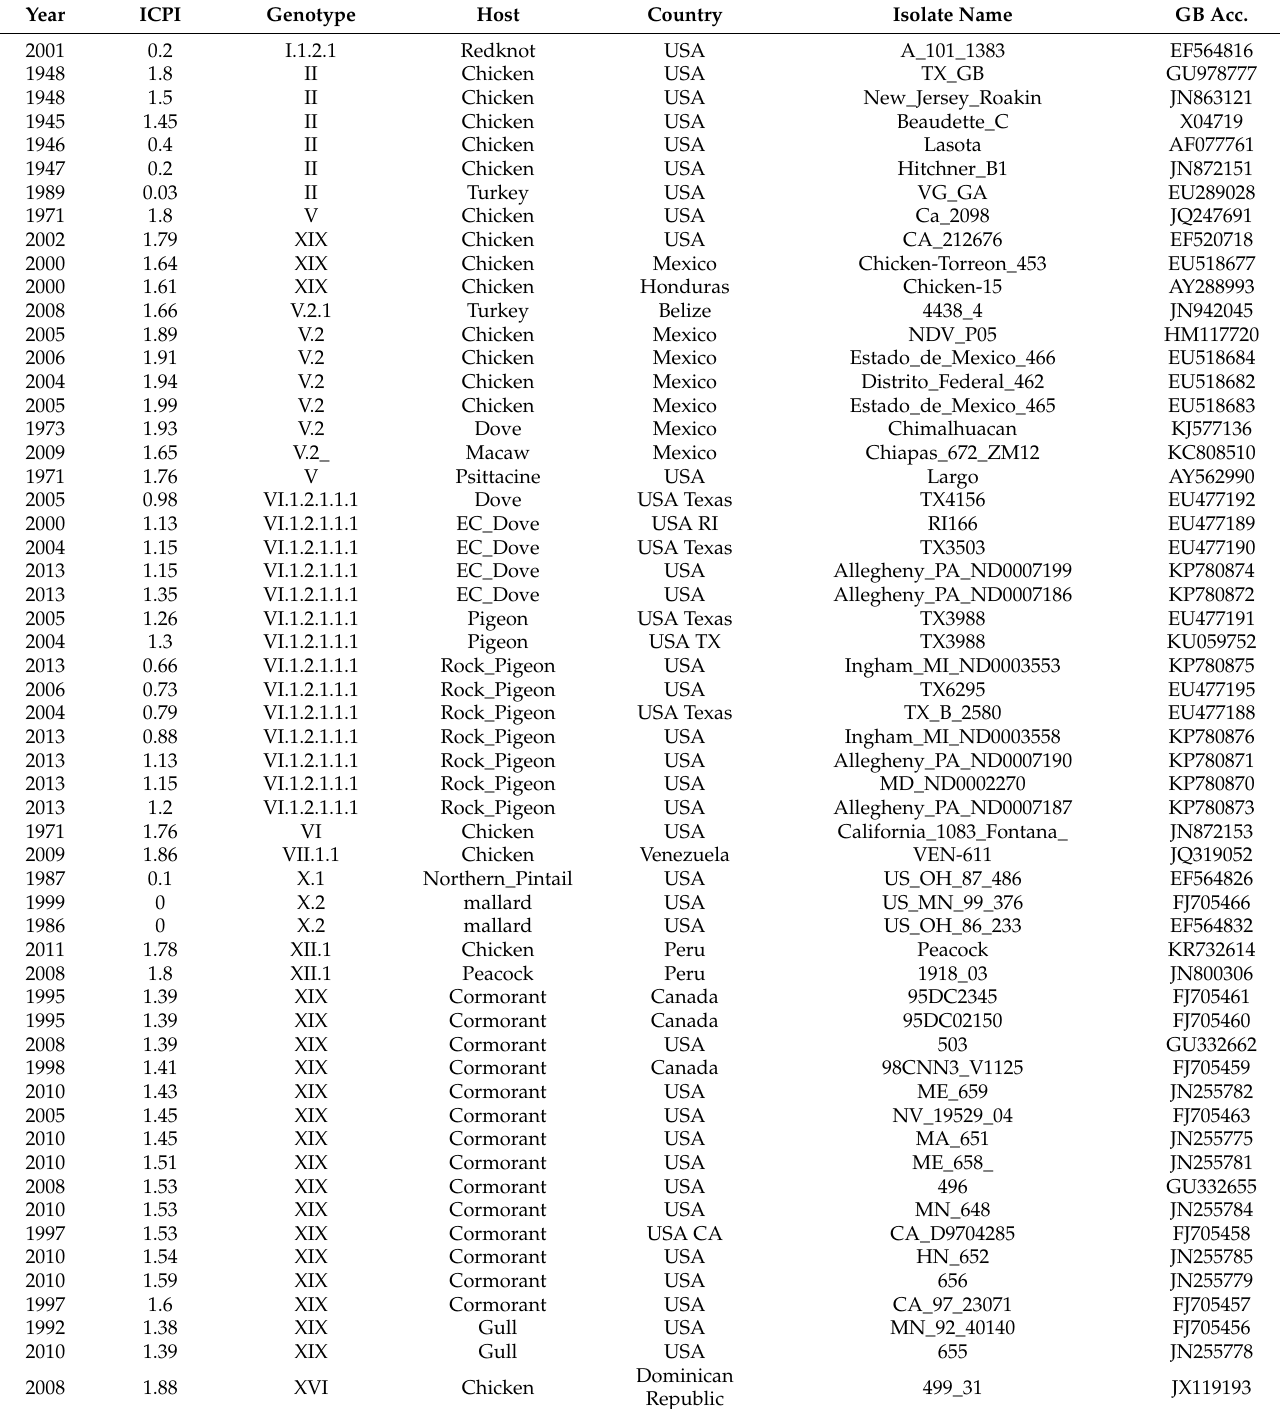
Table 1. Intracerebral pathogenicity index (ICPI) of selected viruses sorted by